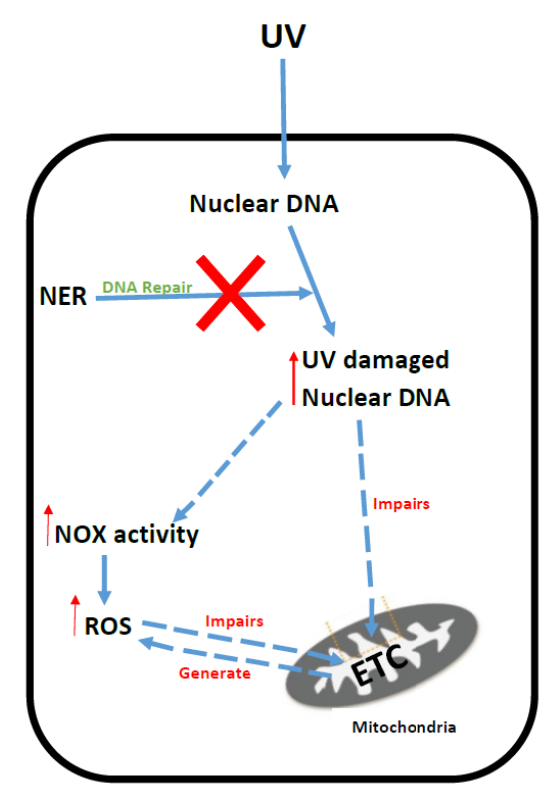
Figure 6. Putative mechanisms of oxidative stress generation and mitochondrial dysfunction in Xeroderma Pigmentation. UV: Ultraviolet radiation; NER: Nucleotide excision repair system; NO x : NADPH oxidase; ETC: Mitochondrial electron transport chain; ROS: Reactive oxygen species.